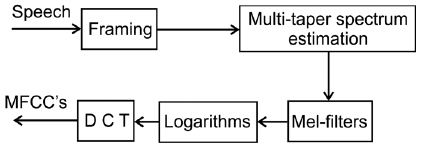
Figure 1. Block Diagram of Multitaper MFCC